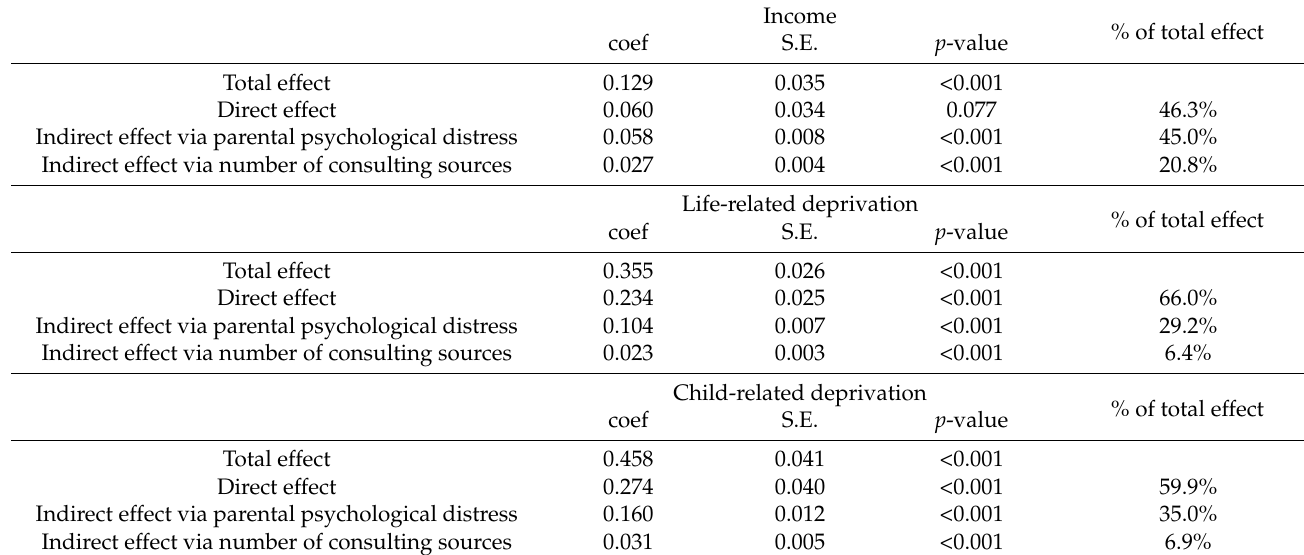
Table 5. Analysis of mediators of child behavioral difficulties (SDQ